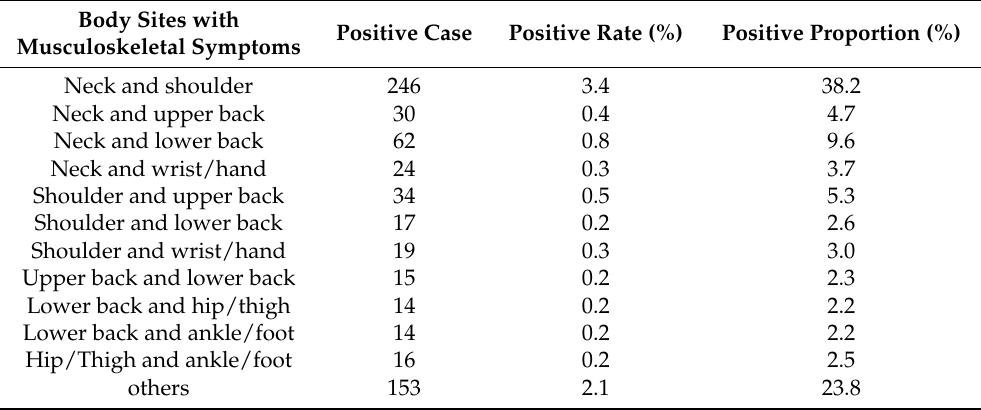
Table 4. Distribution of concurrent musculoskeletal symptoms in two body sites of participants in the past 12 months. ( n = 644).